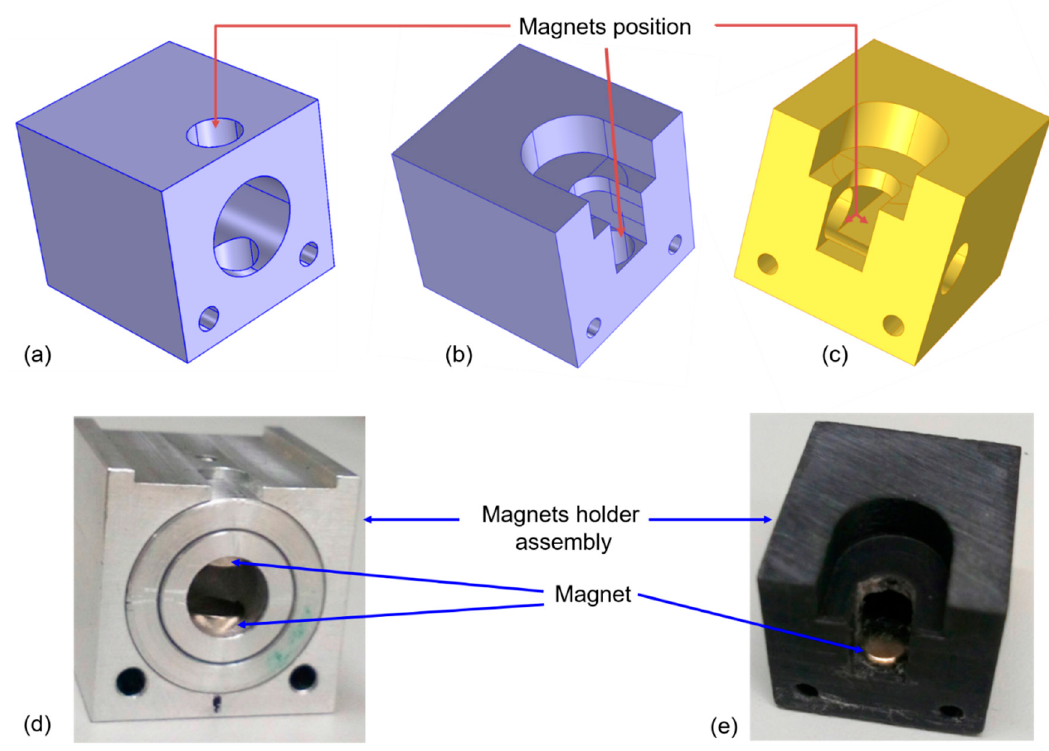
Figure 3. Magnet holder assembly. Typical designs( a – c ) and fabricated samples ( d , e